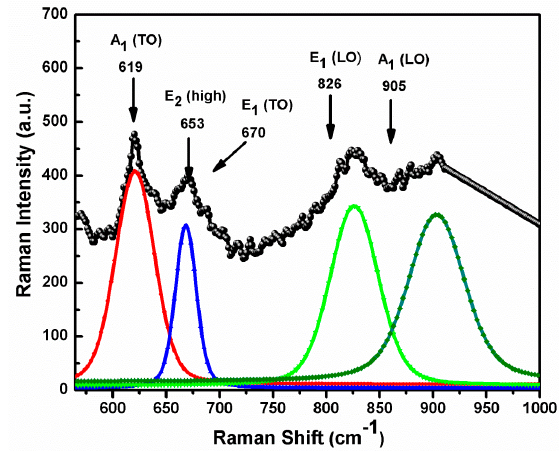
Figure 6. Raman spectra of AlN nanoparticles deposited on the silicon substrate.